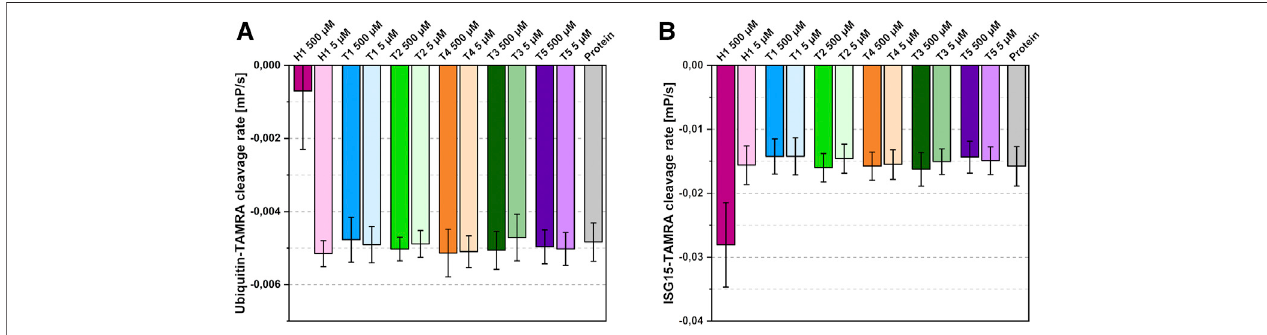
FIGURE 5 | Effects of the identi fi ed binders on substrate cleavage rates. (A) Ubiquitin-cleavage rate of PLpro in the presence of 500 µM or 5 µM compound. (B) ISG15-cleavage rate of PLpro in the presence of 500 µM or 5 µM compound. Compounds coloured according to Figure 3 ; protein shown in grey. Average of four independent experiments with standard deviation